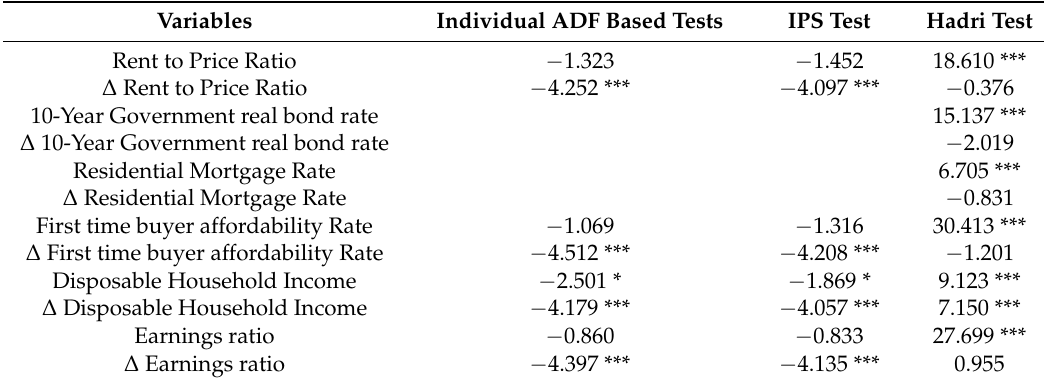
Table 1. Unit Root Tests for Stationarity.